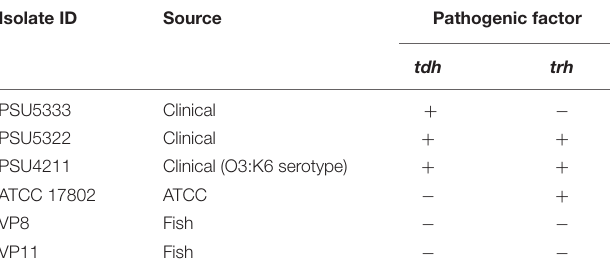
TABLE 1 | V. parahaemolyticus strains used for bacteriophages isolation. Isolate